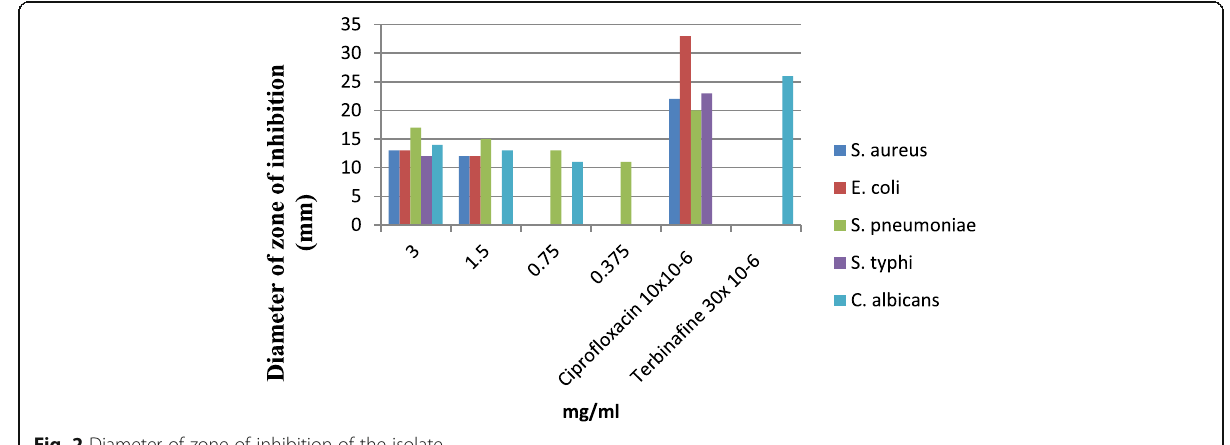
Fig. 2 Diameter of zone of inhibition of the isolate